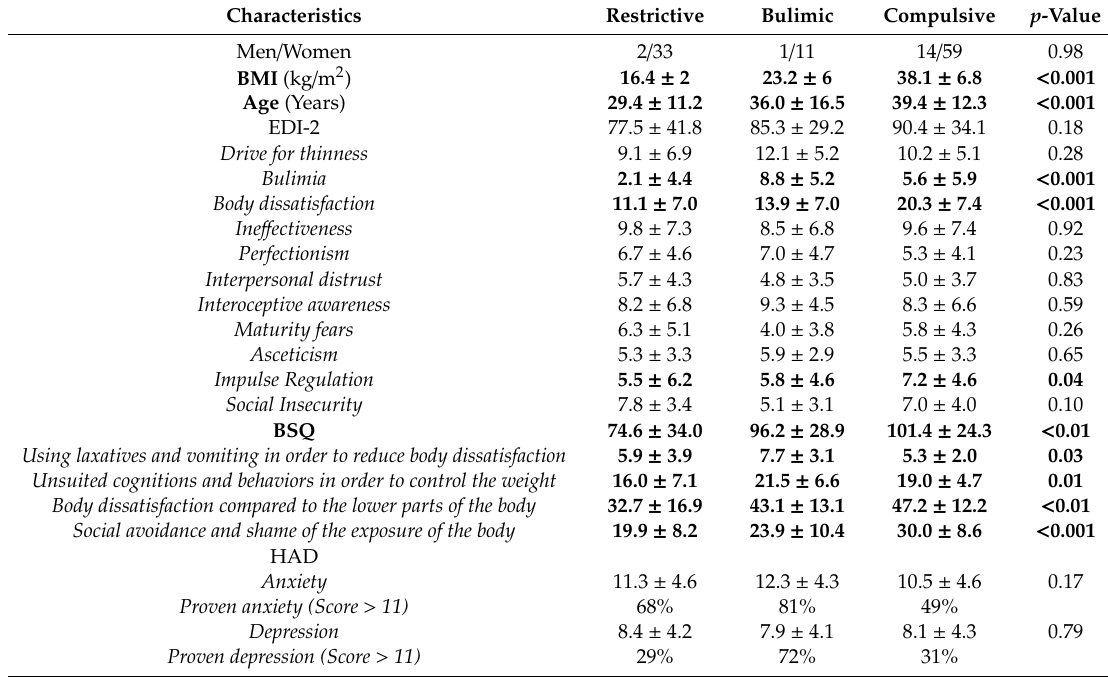
Table 1. Characteristics of patients according to the form of ED ( n =